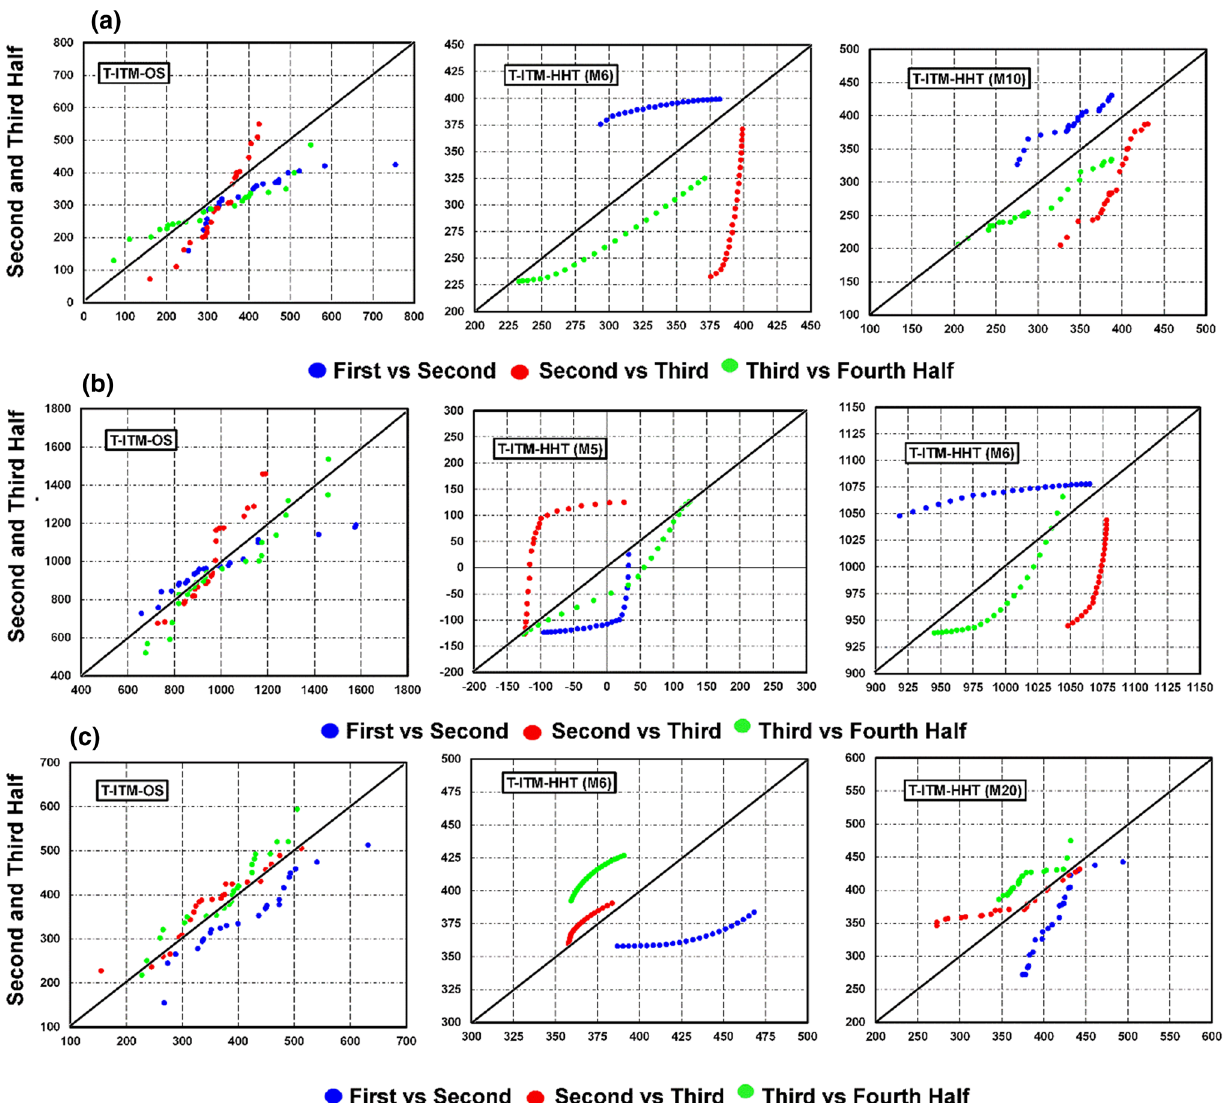
Fig. 9 Representations and comparison of the results of the application of the Triple-innovative trend method (T-ITM) on the original series (left side) and some proposed models using HHT (hybrid approach) at a Oued Taria, b Azazga, and c Ain Beida